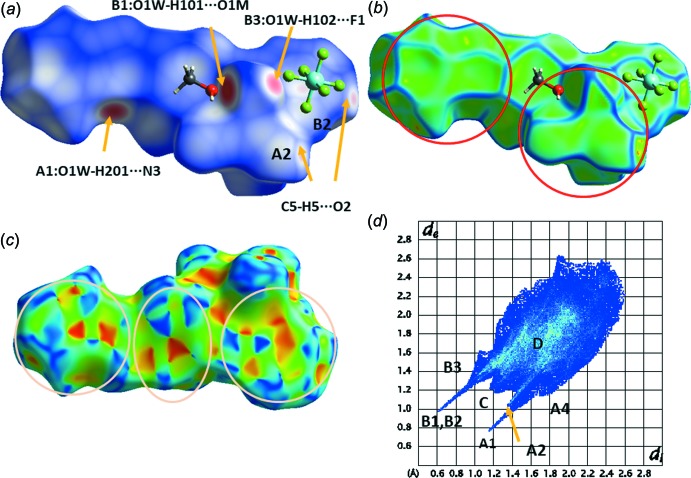
Views of the Hirshfeld surfaces mapped over (a) d
norm, (b) curvedness and (c) shape-index, and (d) the fingerprint plot for the title complex. The red circles in (b) indicate patches of the same shape corresponding to contact areas of neighbouring complexes. The central ellipse in (c) indicates the π–π overlap of the central phenyl rings, and the two circles at both ends of the surface the overlap of the pyridine ring and the phenyl ring of the benzo­thia­zol part of neighbouring centrosymmetrically related NNbz ligands. In (d), d
e and d
i are the distances to the nearest atom centre exterior and inter­ior to the surface. A1 and A4 stand for the acceptor atoms in O1W—H201⋯N3 and C⋯H inter­actions. A2, B2 indicate the acceptor atom and the H-donated atom in the C5—H5⋯O2 inter­action, B1 the H101 atom in the O1W—H101⋯O1M inter­action, and B3, C and D the H⋯F, H⋯H and C⋯C inter­actions, respectively.